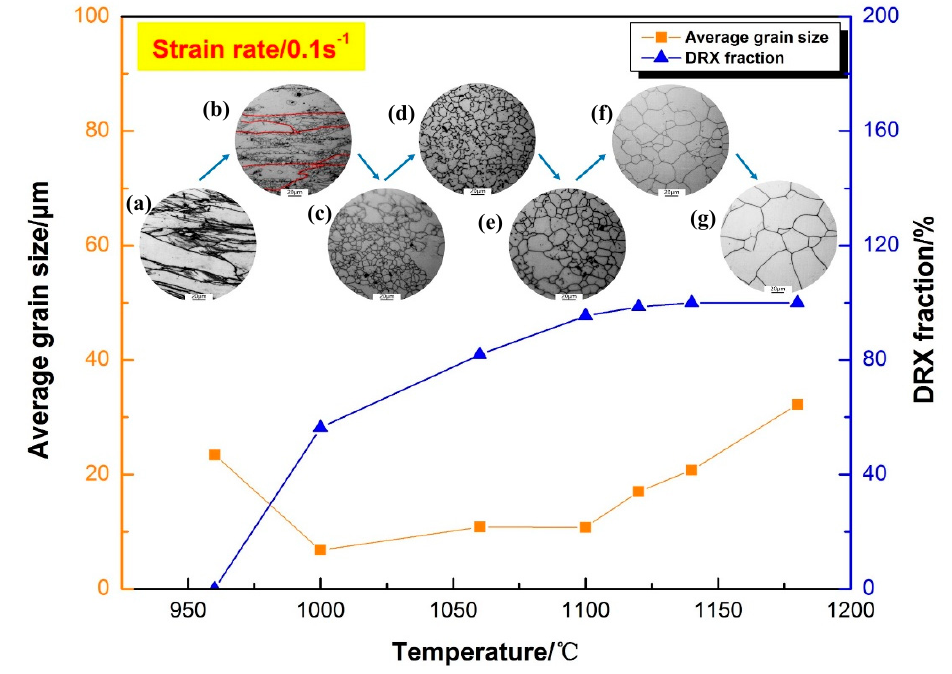
Figure 10. Schematic diagram of grain size, DRX fraction and optical microstructure of the specimens deformed at the strain rate of 0.1 s − 1 : ( a ) 960 °C, ( b ) 1000 °C, ( c ) 1060 °C, ( d ) 1100 °C, ( e ) 1120 °C, ( f ) 1140 °C, ( g ) 1180 °C.